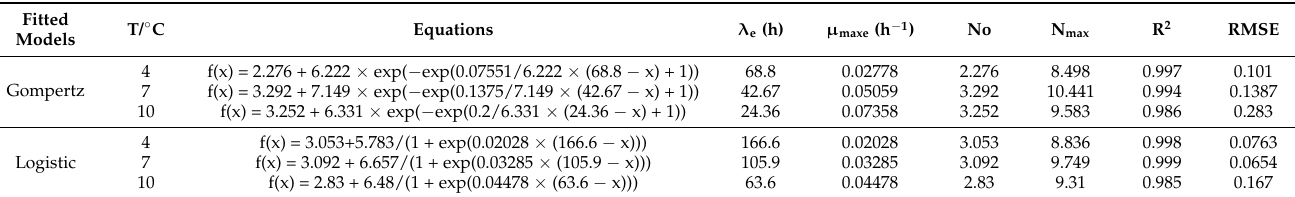
Table 1. The primary growth models of S. putrefaciens in tuna at different temperatures based on modified Gompertz and logistic equation by CFU. Fitted